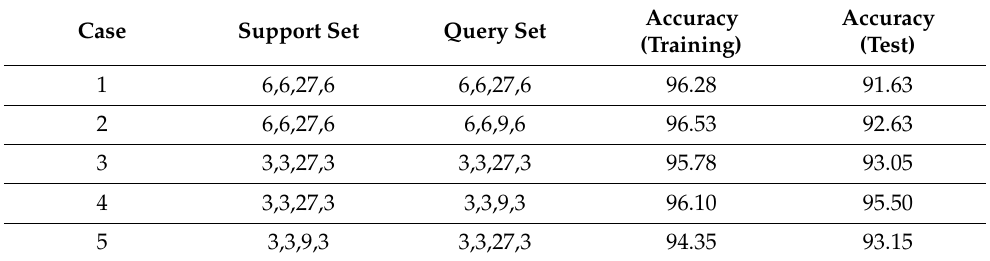
Table 2. Convolutional blocks for support and query